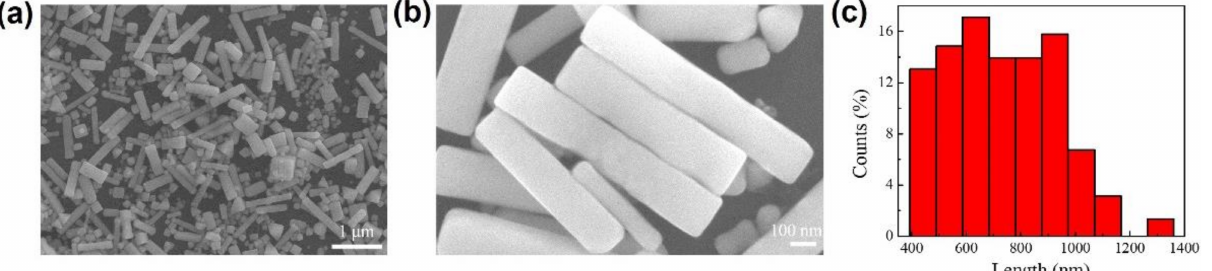
Figure 1. The characterization of large-size Ag nanobar. ( a ) Scanning electron microscope (SEM) image of Ag nanobars. ( b ) The high-magnification SEM image of Ag nanobars. ( c ) The length distribution map of Ag